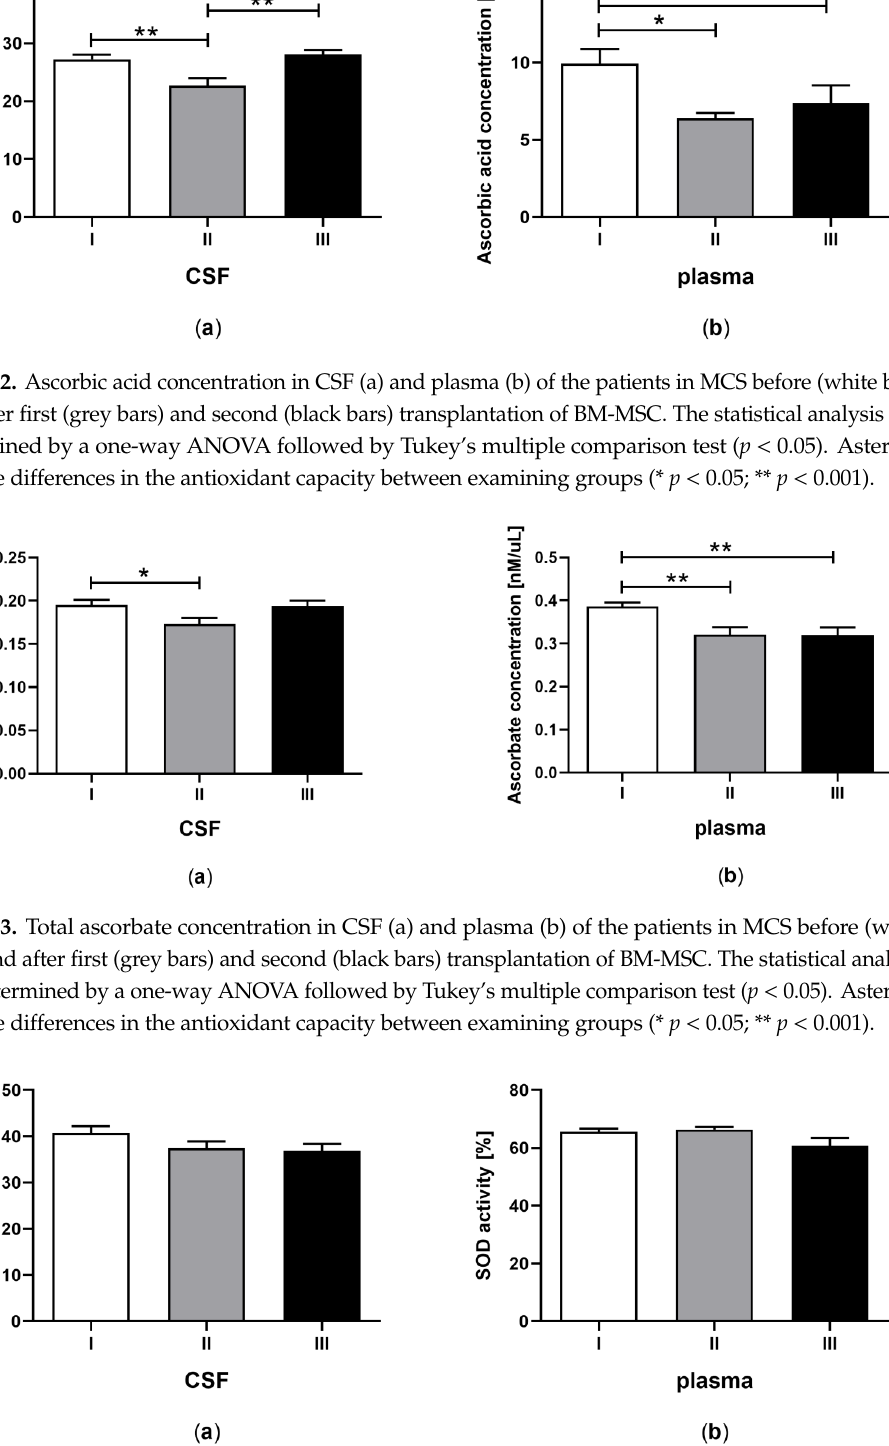
Figure 2. Ascorbic acid concentration in CSF (a) and plasma (b) of the patients in MCS before (white bars) and after first (grey bars) and second (black bars) transplantation of BM-MSC. The statistical